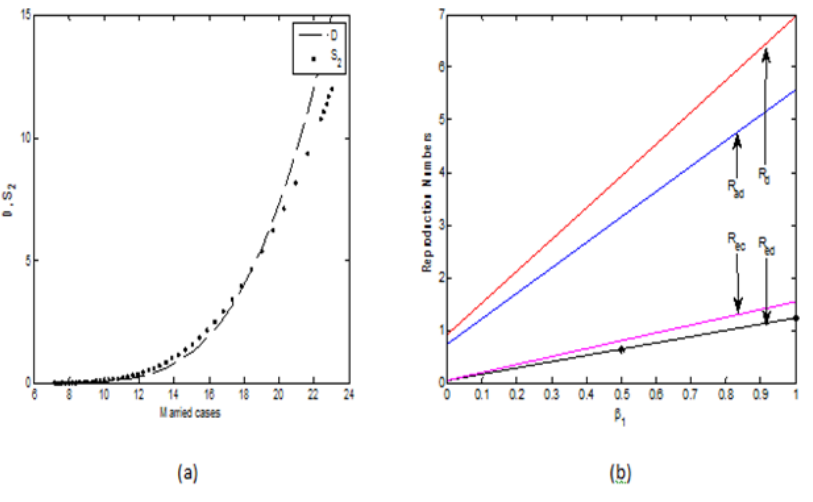
Figure 4. Relationship between (a) Married and the Divorced/Separated cases and (b) the reproduction numbers as a function of β 1 using parameter values in Table